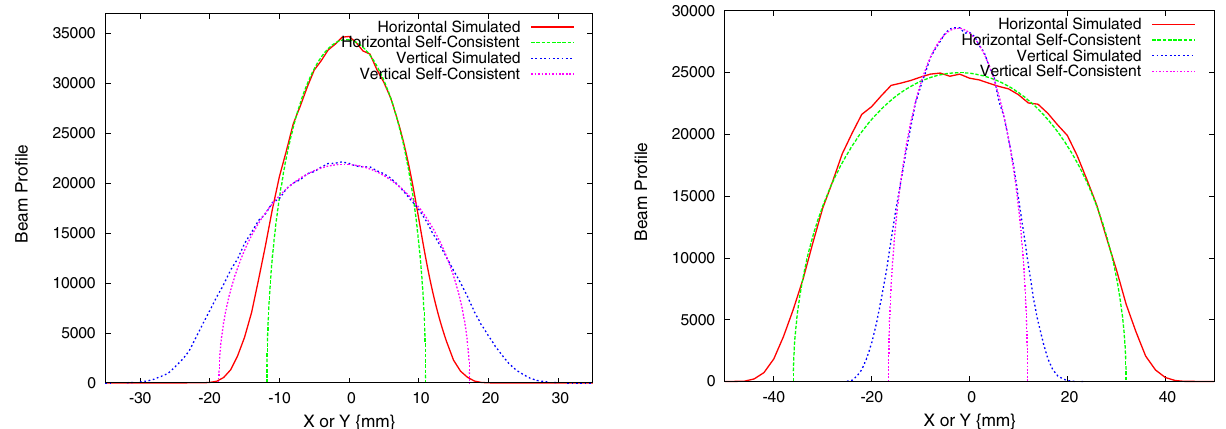
FIG. 13. Horizontal and vertical profiles of the accumulated beam taken at the locations of the electron scanner in the ring (left) and at wire scanner WS20 in the RTBT (right). A comparison with the superimposed self-consistent profiles indicates that the accumulated beam demonstrates self-consistent profile